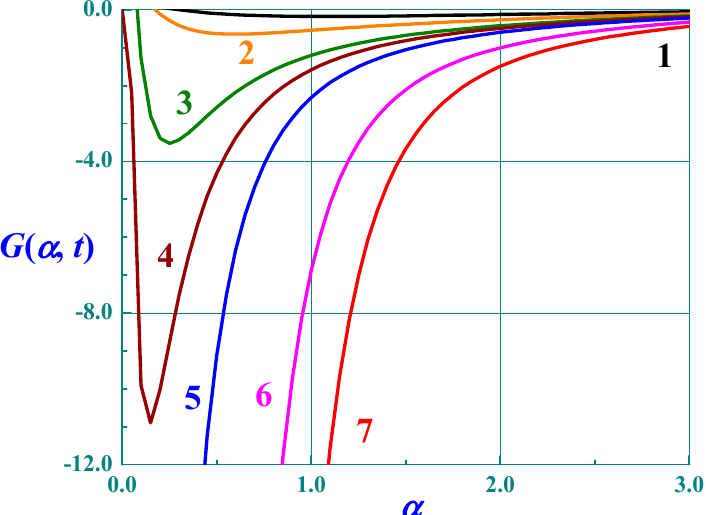
Figure 2. G ( α , t )—First derivatives of the Mittag-Leffler functions with respect to α plotted at constant values of t . 1—0.25; 2—0.50; 3—0.75; 4—0.85; 5—1.0; 6—1.5; 7—2.0.